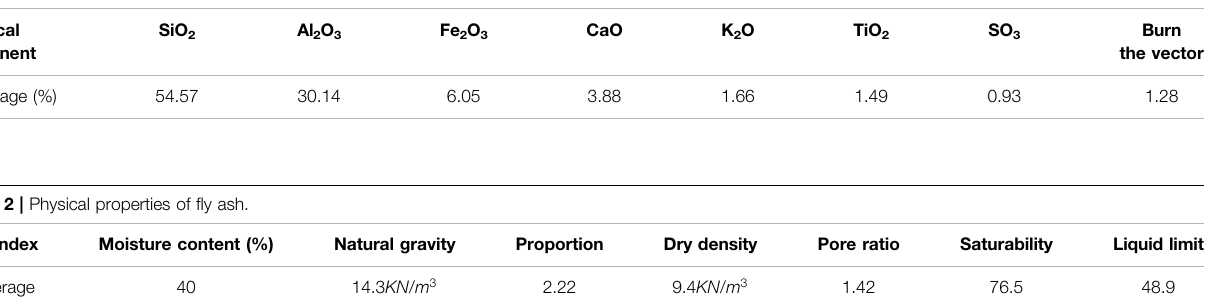
TABLE 1 | Chemical properties of fl y ash.